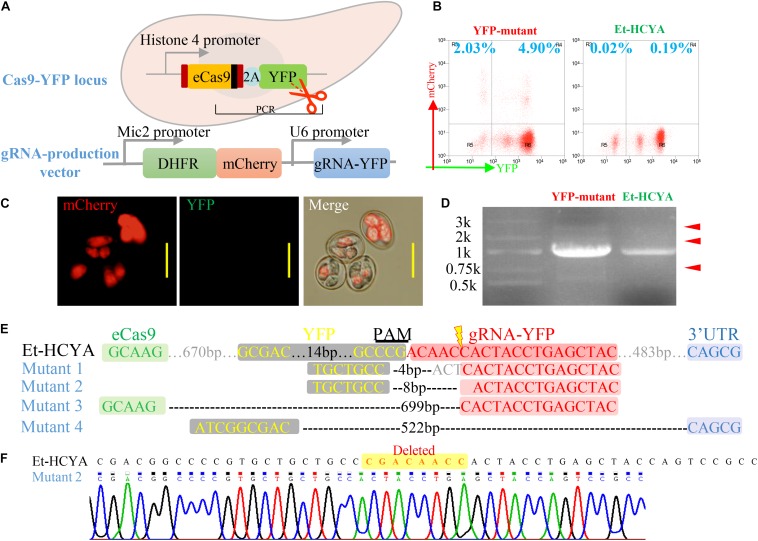
CRISPR/Cas9-mediated YFP mutagenesis in transgenic EtHCYA. (A) Schematics showing the mutagenesis strategy by transfecting a vector encoding a gRNA targeting endogenous yfp locus in Et-HCYA. (B) The mutation rate of the transfected oocysts was analyzed by flow cytometry. Left: Et-HCYA transfected with gRNA-producing vector; Right: Et-HCYA control. (C) Fluorescence observation of mutant oocysts under microscope. Bar = 20 μm. (D) Cleaved yfp loci in the transfected population were identified by PCRs, and all the mutated amplicons (red arrowhead) were cloned and sequenced. (E) All detected mutations in the yfp loci induced by Cas9 cleavage. (F) Chromatogram of mutant 2.